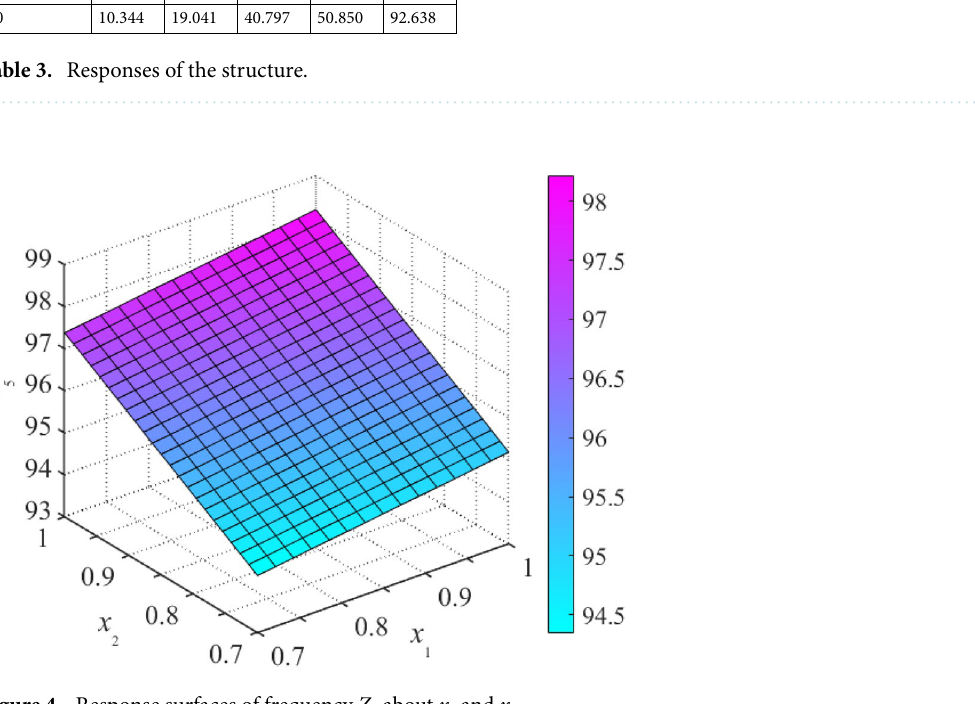
Figure 4. Response surfaces of frequency Z 5 about x 1 and x 2